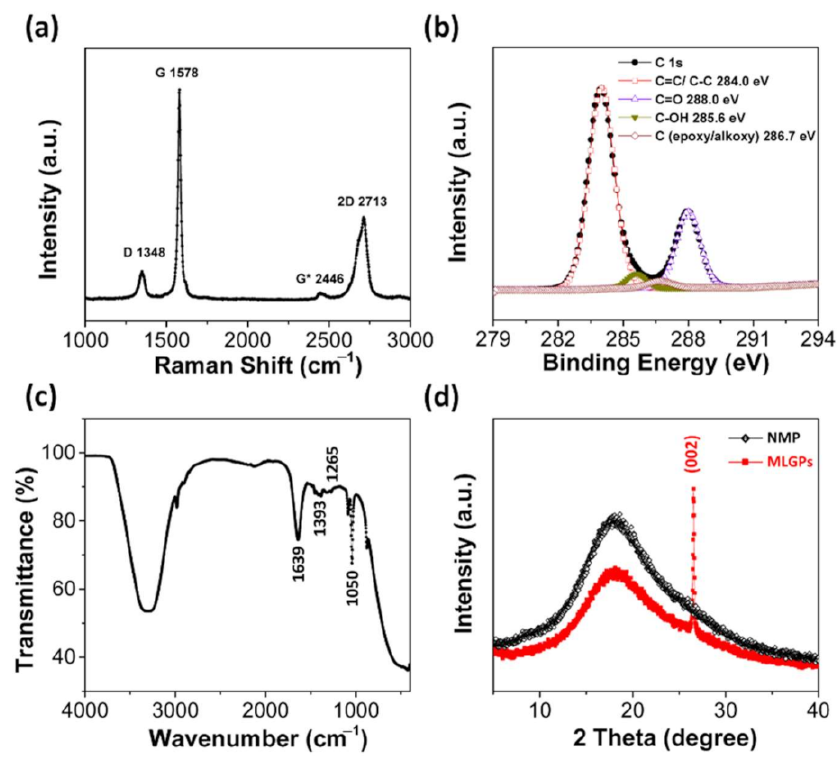
Figure 3. Raman ( a ), XPS ( b ), IR ( c ), and XRD ( d ) spectra of